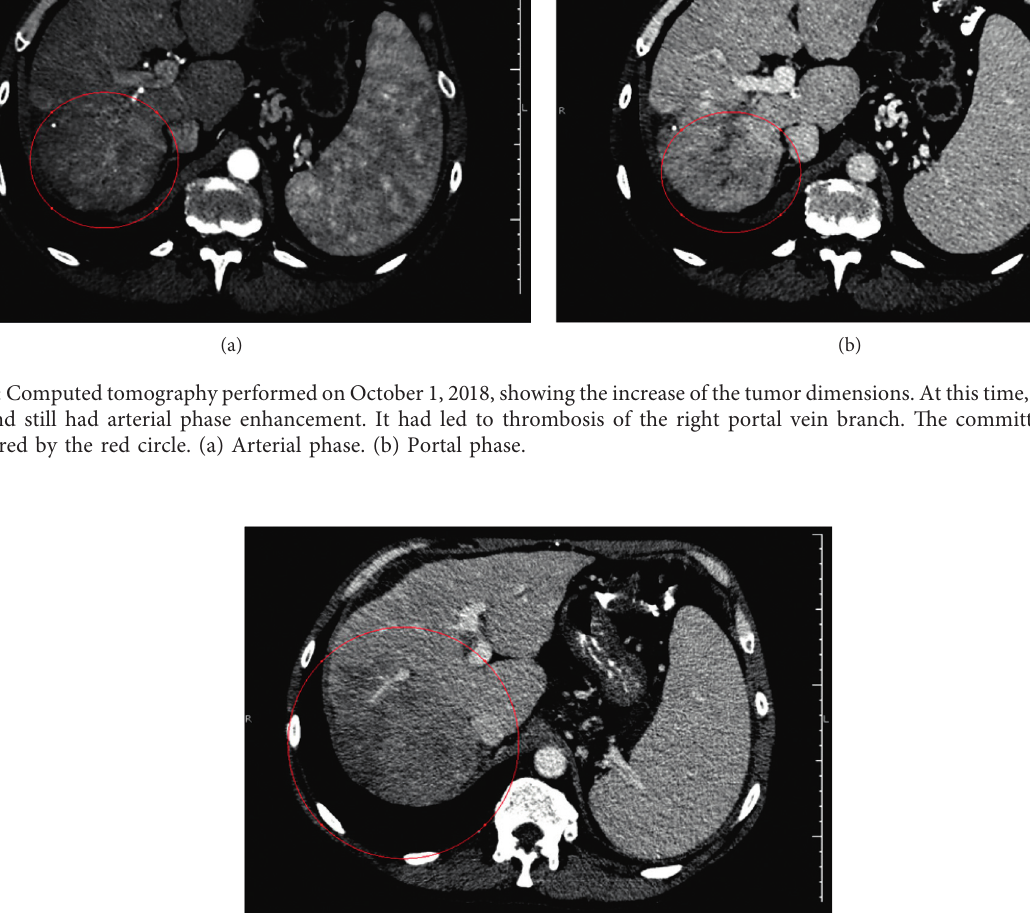
Figure 3: Computed tomography performed on February 18, 2019, showing a new progression of the tumor dimensions, now achieving 11.7cm. The image was obtained during the arterial phase, but the arterial enhancement was changed to a radiolucent area underscored by the red circle.